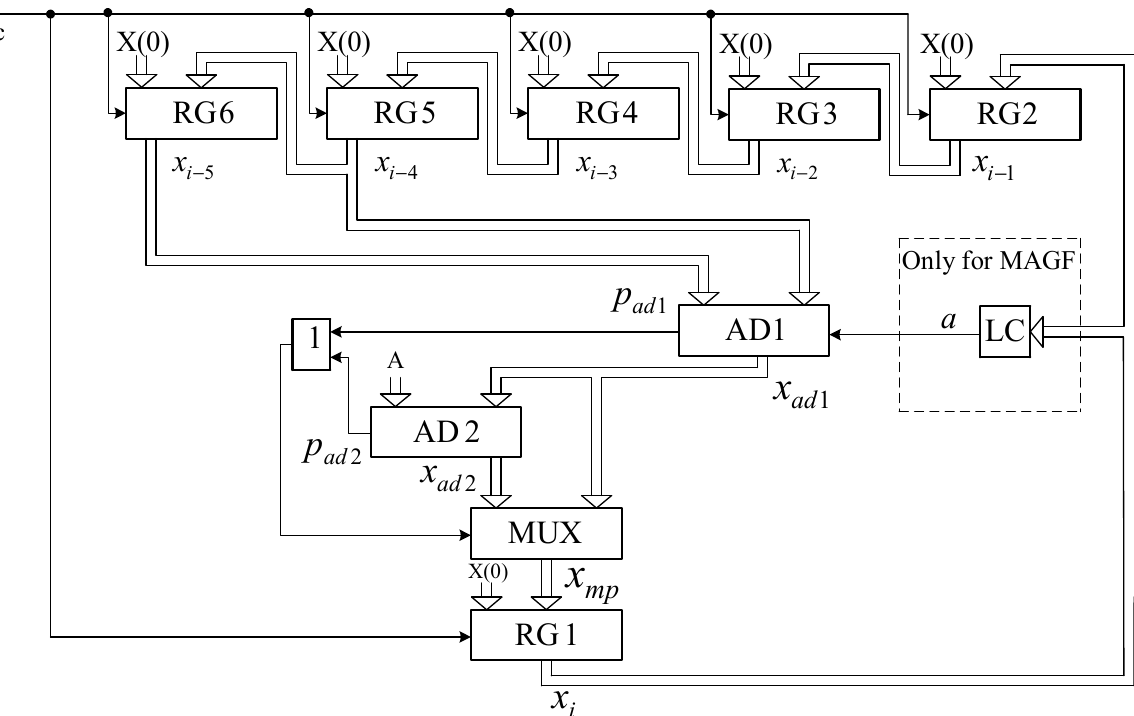
Figure 1. Structure scheme of AFG and MAFG.